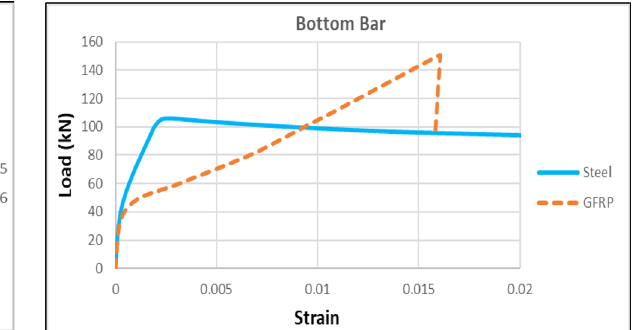
Figure 16: Strain of the bottom bar for specimens beams steel and GFRP.